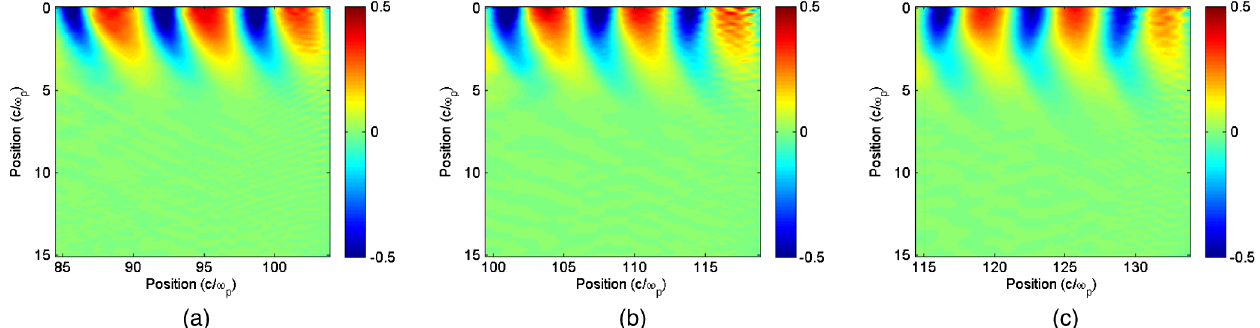
FIG. 4. Evolution of the measured density modulation profile resulting from diffraction after the interaction with the wakefield. (a) The profile when it just finishes interacting with the wakefield, (b) when it propagates 18 μ m from the previous picture and (c) after it propagates 36 μ m from the first picture. The shape of the modulated profile is changing and decreases in amplitude as it propagates further from the interaction point.